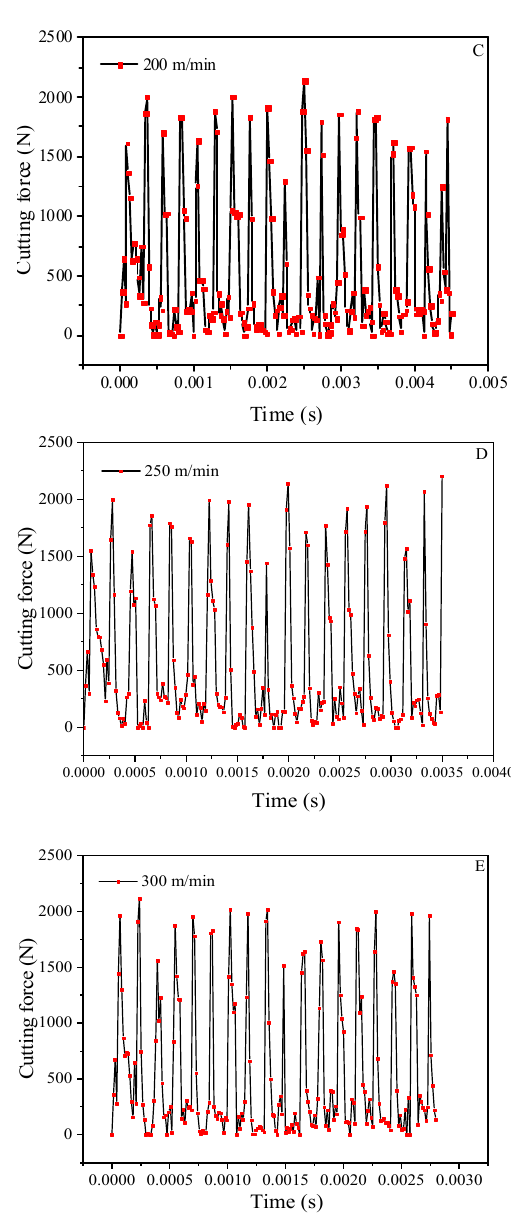
Figure 4. Curves of the cutting force at different milling speeds. ( A ) 100 m/min. ( B ) 150 m/min. ( C ) 200 m/min. ( D ) 250 m/min. ( E ) 300 m/min.